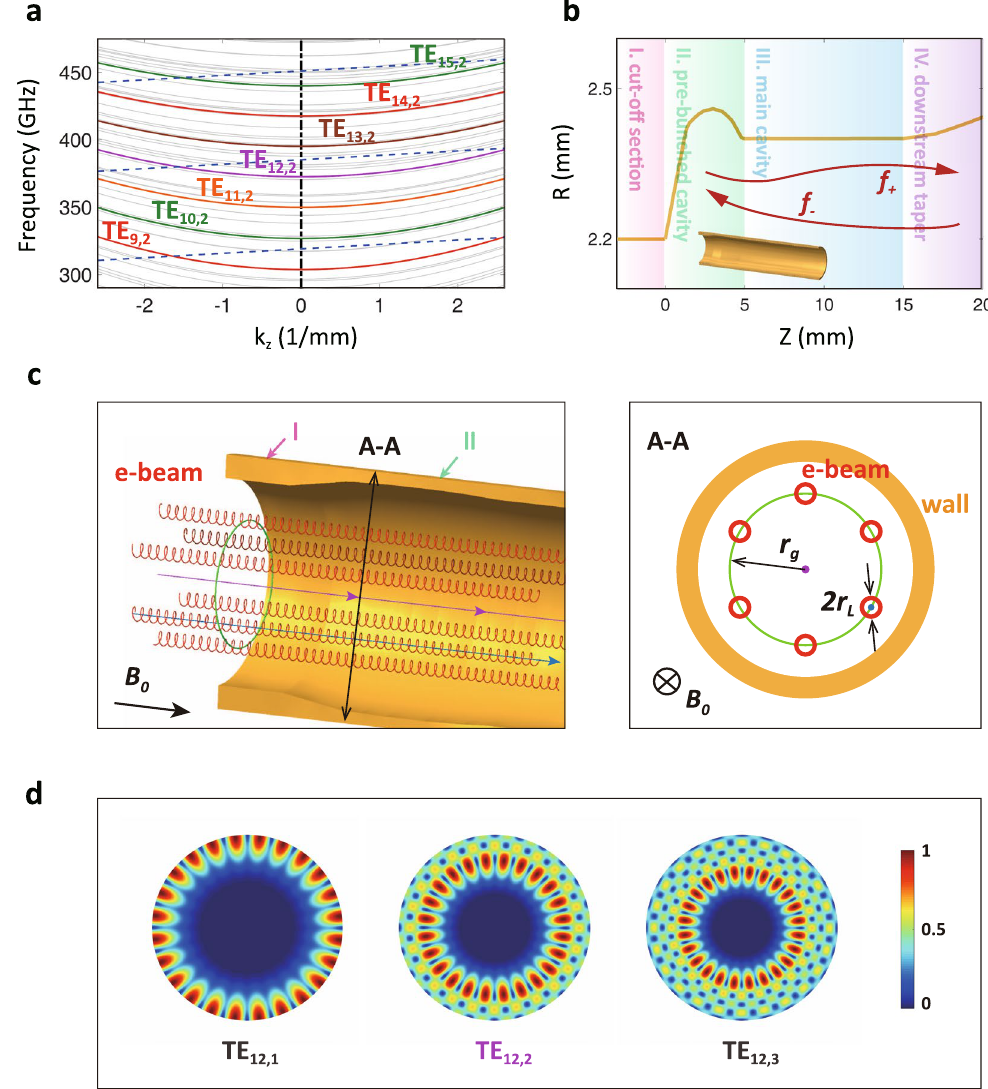
Figure 1. Dispersion and ECM schematic in the pre-bunched structure. ( a ) The cold dispersion relation of multi-mode switching. The colorful curves represent operating modes, and the grey curves represent potential competing modes. The dashed lines represent fundamental harmonic helical electron beam during magnetic tuning. The operating points of concerned backward-wave interaction is located at the left dispersion plane. ( b ) The profile of the pre-bunched backward-wave interaction circuit in gyrotron with four parts. f + and f − indicates forward wave and backward wave, respectively. ( c ) A schematic diagram of the electron movement trajectory in gyrotron. Different electron guiding centers are distributed in the green circles which heads along the blue arrows. Electrons orbit along the guiding centers by spiral movement. ( d ) The normalized horizontal electric field distribution of representative circular waveguide TE 12,1 , TE 12,2 and TE 12,3